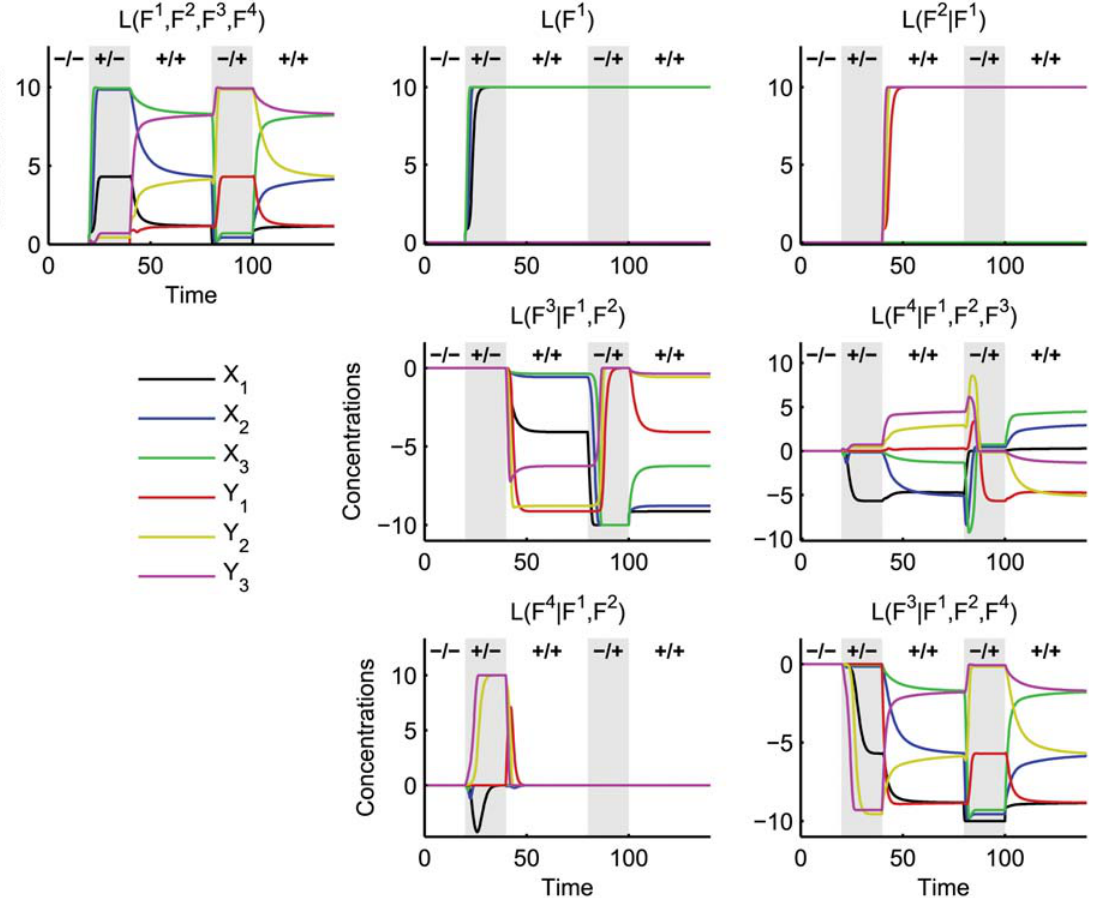
Fig 5. Layer dynamics of the crosstalk example. Dynamics of the layers for switching between different input combinations: (-/-) S 1 = S 2 = 0; (+/-) S 1 = 5, S S S S S 2 = 0; (+/+) 1 = 2 = 5; and (-/+) 1 = 0, 2 = 5. The top left figure corresponds to the dynamics of the complete network, the central and right top figure to the dynamics of the two isolated signalling pathways without any crosstalk. If the mutually inhibitory crosstalk L ( F 3 j F 1 , F 2 ) is added first, the network becomes bistable, then monostable again by then including the mutually excitatory crosstalk L ( F 4 j F 1 , F 2 , F 3 ). Adding first the excitatory crosstalk L ( F 4 j F 1 , F 2 ) leads to strong cross-activation of the pathways, which is significantly weakened by the mutual inhibitory crosstalk L ( F 3 j F 1 , F 2 , F 4 ).